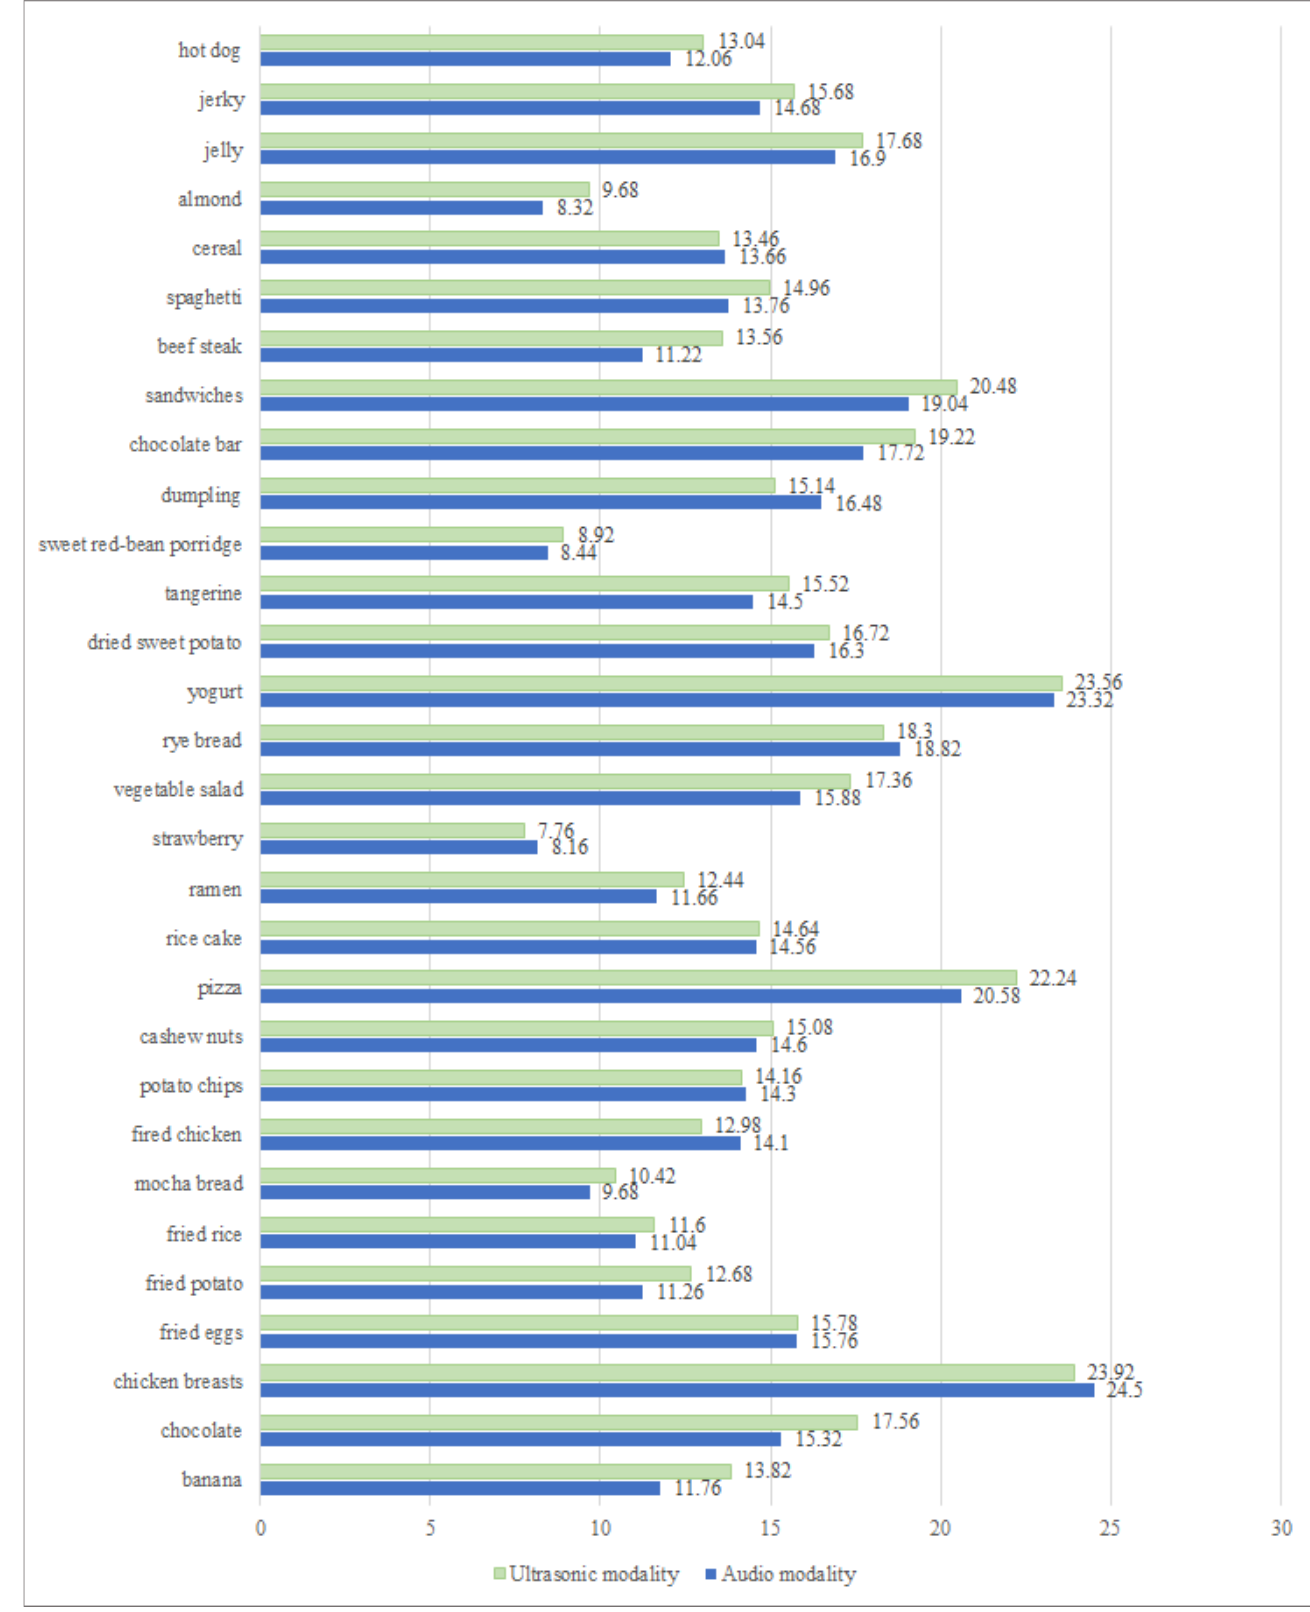
Figure 8. The MAPEs for each modality and each food